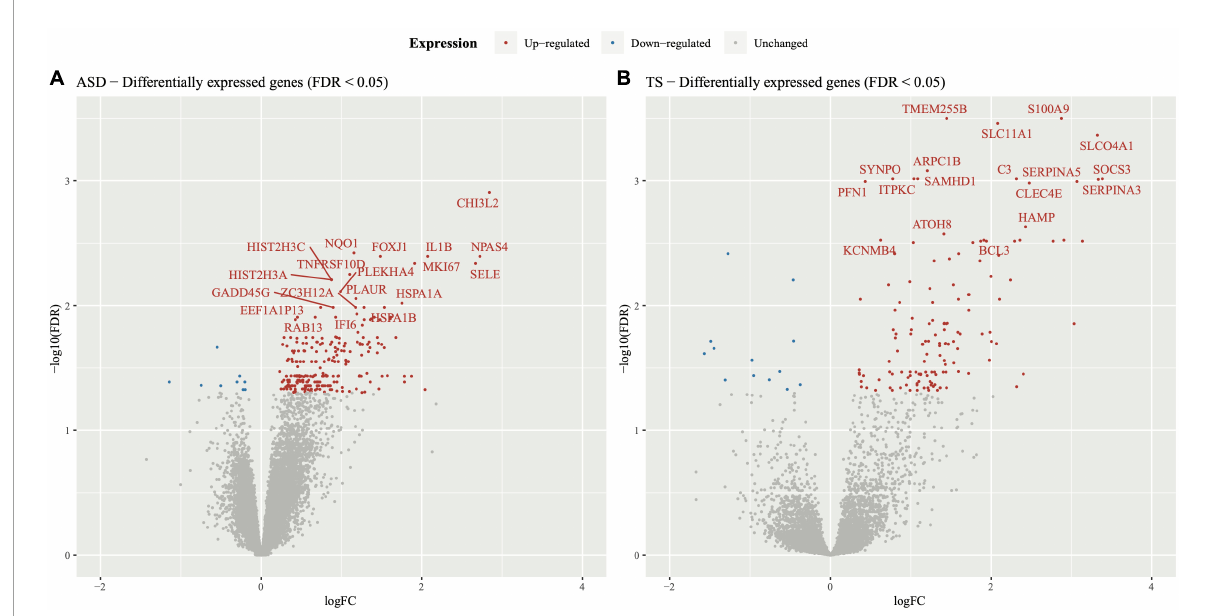
FIGURE1 Volcano plot of differentially expressed genes in autism spectrum disorders (ASD) and Tourette syndrome (TS). Differential gene expression analysis was performed on the transcripts of (A) ASD cases and neurotypical controls and (B) TS cases and neurotypical control samples. The y-axis represents statistical significance ( − log10FDR) and the x-axis represents gene expression log fold change (logFC). The top 20 differentially expressed genes were labelled for ease of viewing, all of which had an upregulated expression in both the ASD and TS